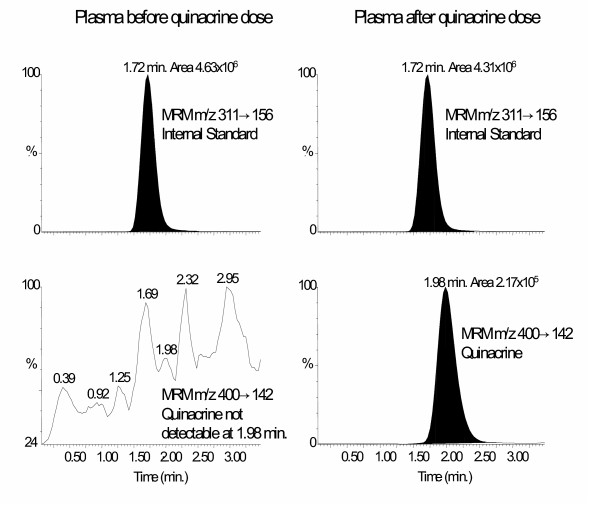
LC/MS/MS chromatograms of quinacrine in mouse plasma